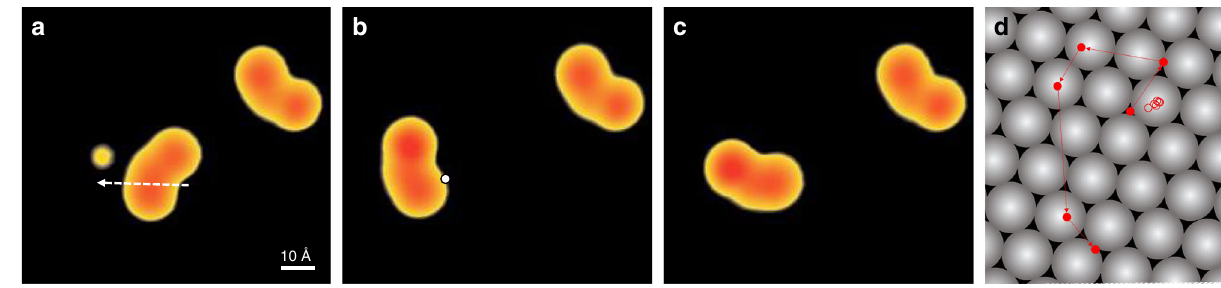
Fig. 4 Pivot point destabilization with a single adatom. a STM image (0.73 V, 0.32 pA) of two DDNB molecules and a single Ag adatom on Ag(111). The dotted arrow indicates the pathway of a lateral manipulation to move the lower molecule onto the adatom. b – c Subsequent STM images of the same surface area. A voltage pulse from the STM tip (at the white dot) results in molecular motion, which is no longer centered on the pivot point. The same contrast scale is used in a – c . d The difference in molecular motion during STM manipulation is evident from the location of the molecule during sequences of successive pulses (red circles indicate the position of the NO 2 group as de fi ned in Supplementary Fig. 5; the Ag(111) surface is shown in gray). While a fi xed axis of rotation is found on the fl at surface (open circles), as presented in Fig. 2e – j, a single adatom underneath the molecule destabilizes this axis and results in translation in addition to rotation (solid circles). The complete image series is shown in Supplementary